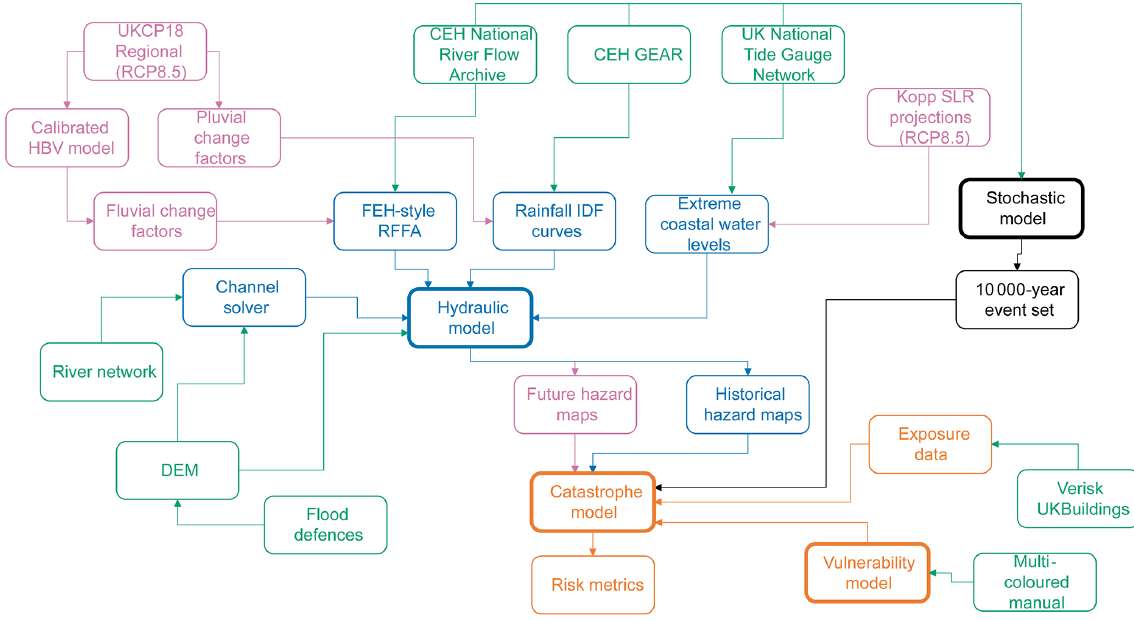
Figure 1. Method employed to compute climate-conditioned UK flood hazard and risk maps using a catastrophe model approach. See Sect. S3.1 to S3.3 for further details. Green cells represent data sources, blue cells represent the hydraulic model and its inputs and outputs, black and orange cells represent the same for the stochastic model, whilst purple cells designate the climate change analysis. Cells in bold represent the four main modelling stages of the